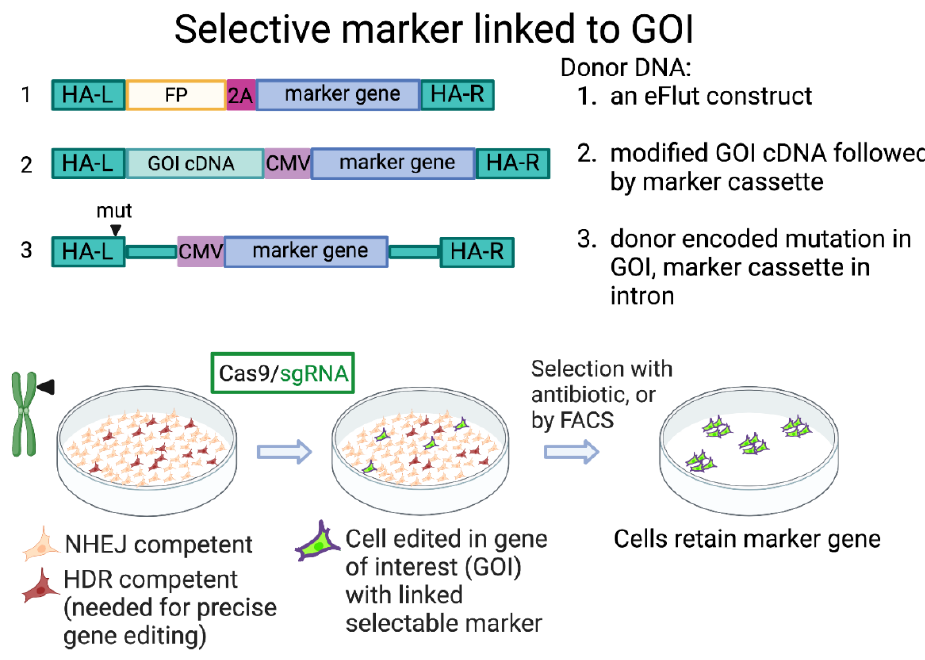
Figure 2. Selection marker linked to gene of interest. The selectable gene is linked directly, or through a 2A peptide, to the gene of interest. Note that the donor construct elements are not to scale. A CMV promoter is depicted as an example of an exogenous promoter. HA-L, HA-R; left and right homology arms, respectively. FP; fluorescent protein. CMV; CMV promoter. Created with BioRen- der.com.